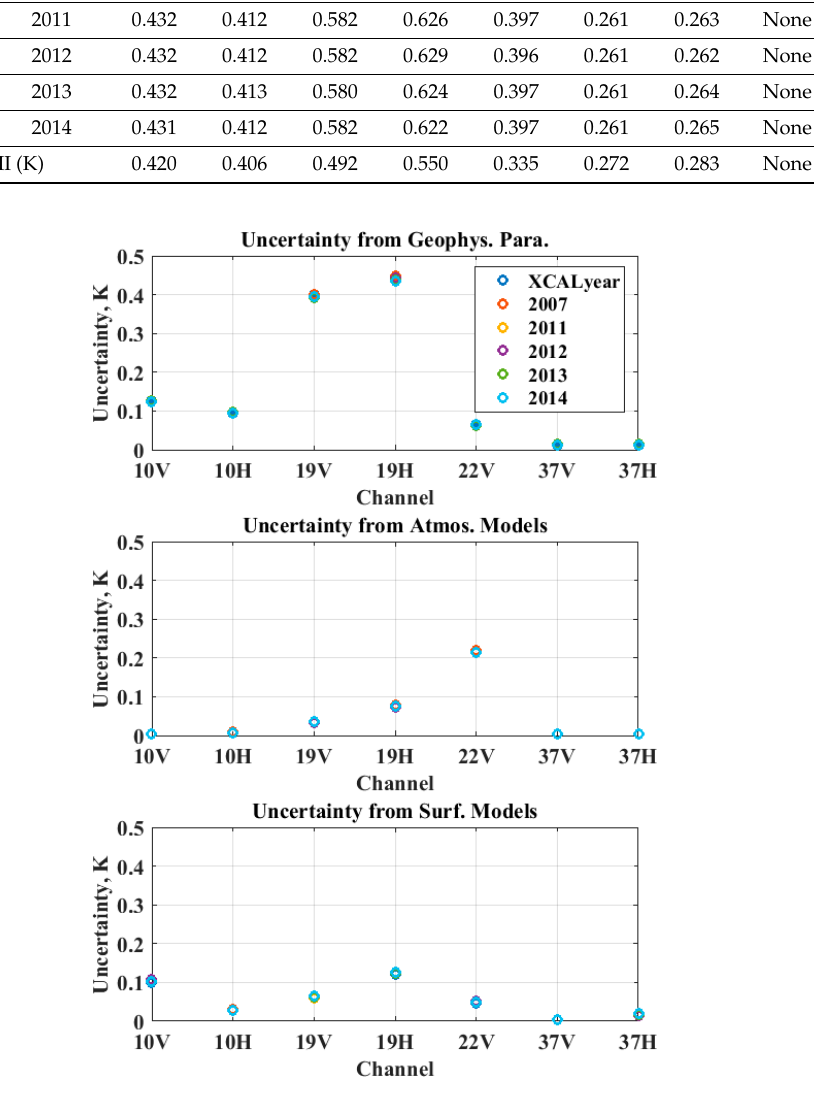
Figure 7. Uncertainty estimates for the six periods of one-year duration, from the three main sources: geophysical filed, atmospheric absorption model and ocean surface emissivity model. Table 8. Combined standard uncertainties for intercalibration of TMI/GMI, TMI/WindSat, and WindSat/TMI.